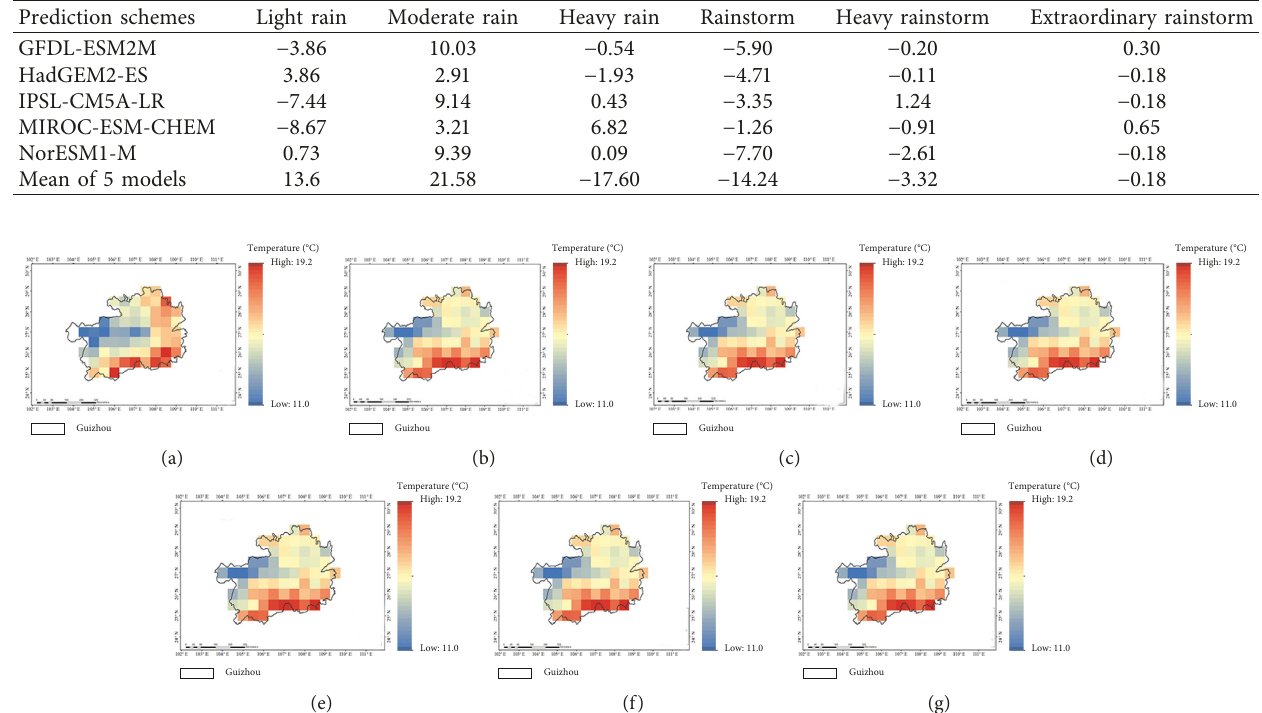
Figure 4: Spatial distribution of temperature. (a)–(g) represent measure, GFDL-ESM2M, IPSL-CM5A-LR, HadGEM2-ES, NorESM1-M, MIROC-ESM-CHEM, and the mean of the five models,